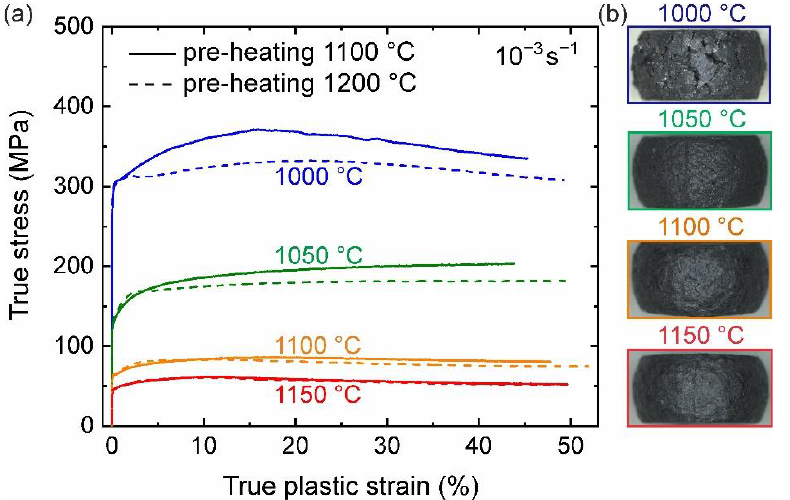
Figure 3. ( a ) True stress as a function of the true plastic strain at a strain rate of 10 −3 s −1 and different pre-heating temperatures. ( b ) Macroscopic images of the samples after deformation at a strain rate of 10 −3 s −1 and a pre-heating temperature of 1100 °C.